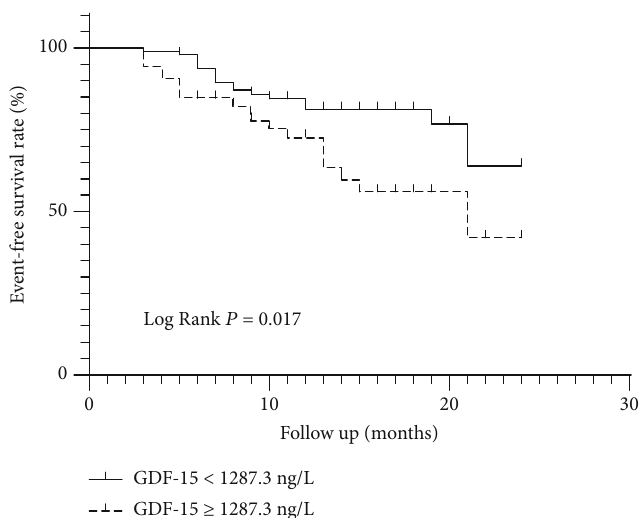
Figure 2: Kaplan-Meier curves of event-free survival rate by GDF-15. Table 2: Univariate and multivariate analysis for atrial fi brillation recurrence.